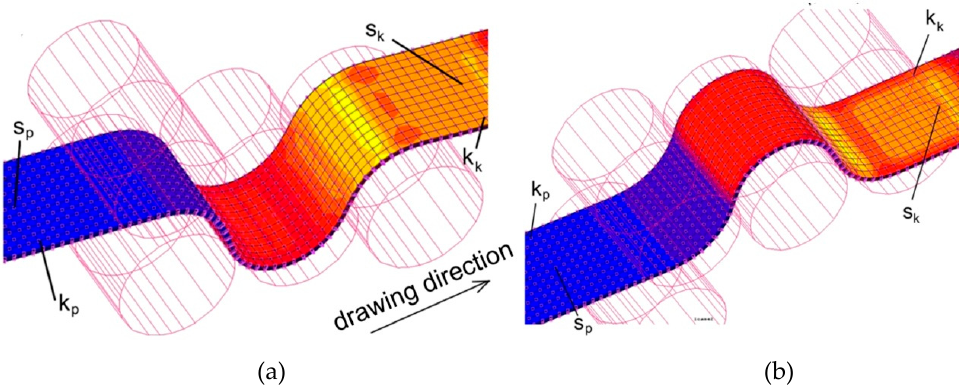
Figure 15. Paths of measuring the equivalent plastic strain on ( a ) the internal and ( b ) external surfaces of specimen: s p and k p —start points, s k and k k —end points.